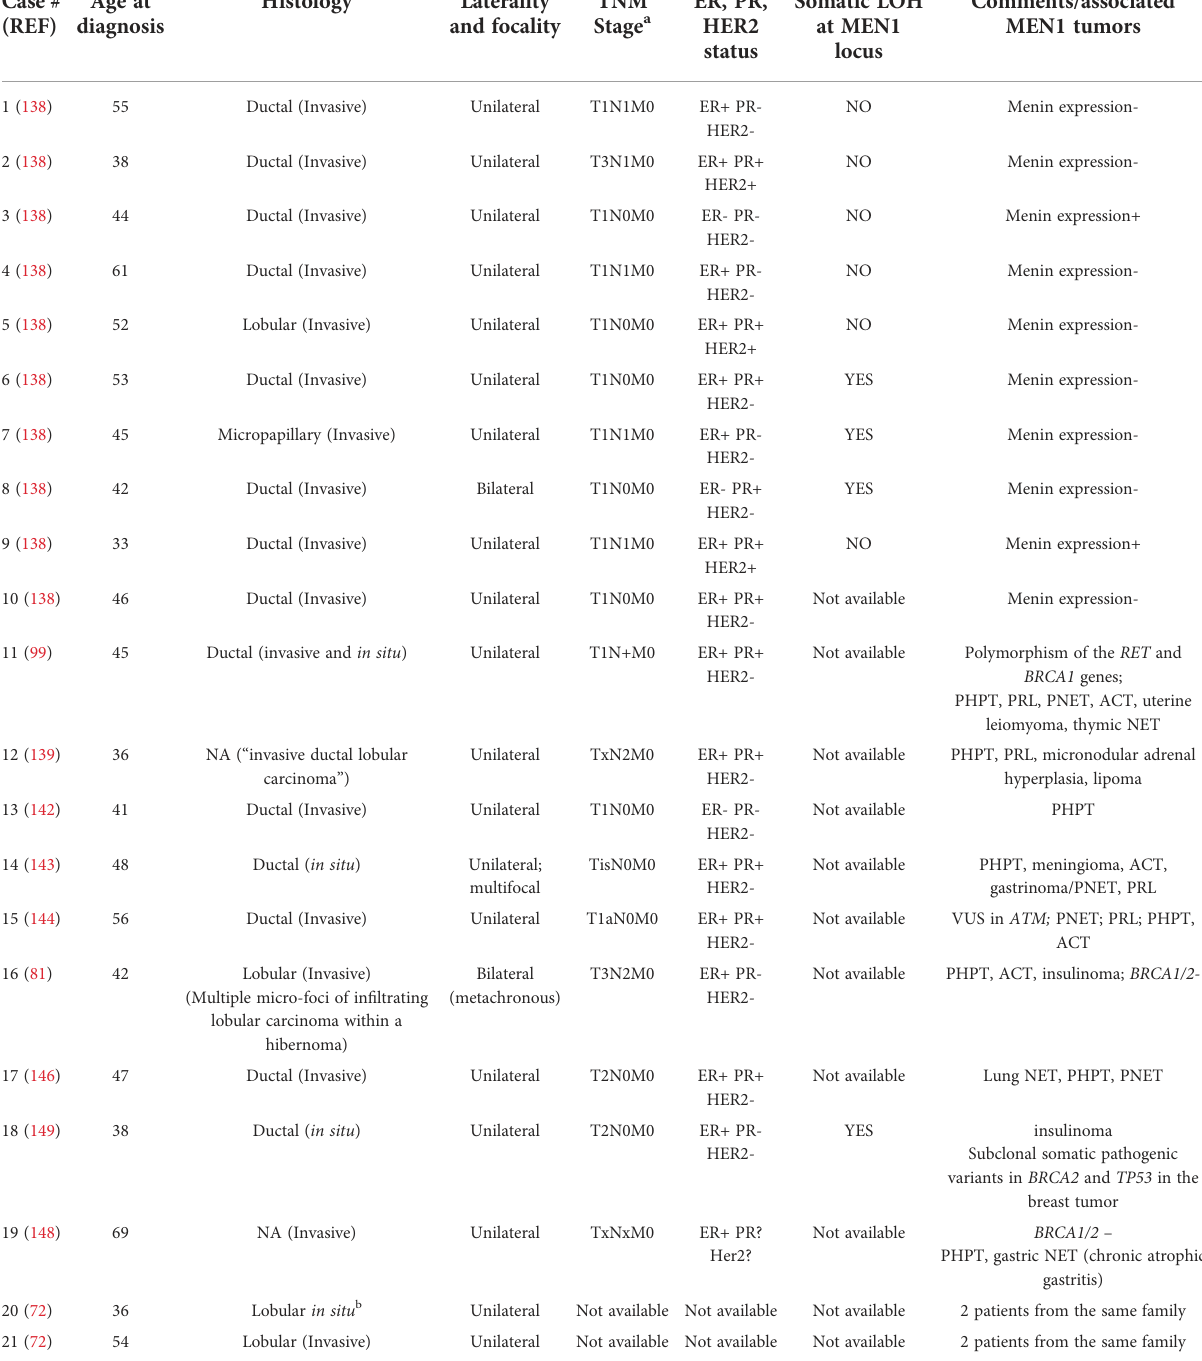
TABLE 2 Clinical details of 21 cases of breast cancer in women with genetically con fi rmed